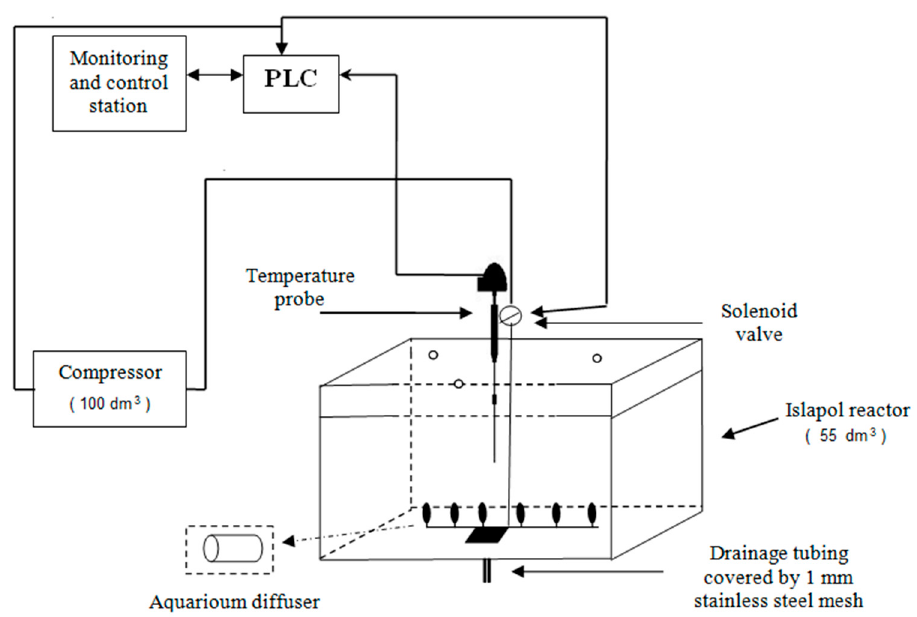
Figure 2. Diagram of the composting reactor.